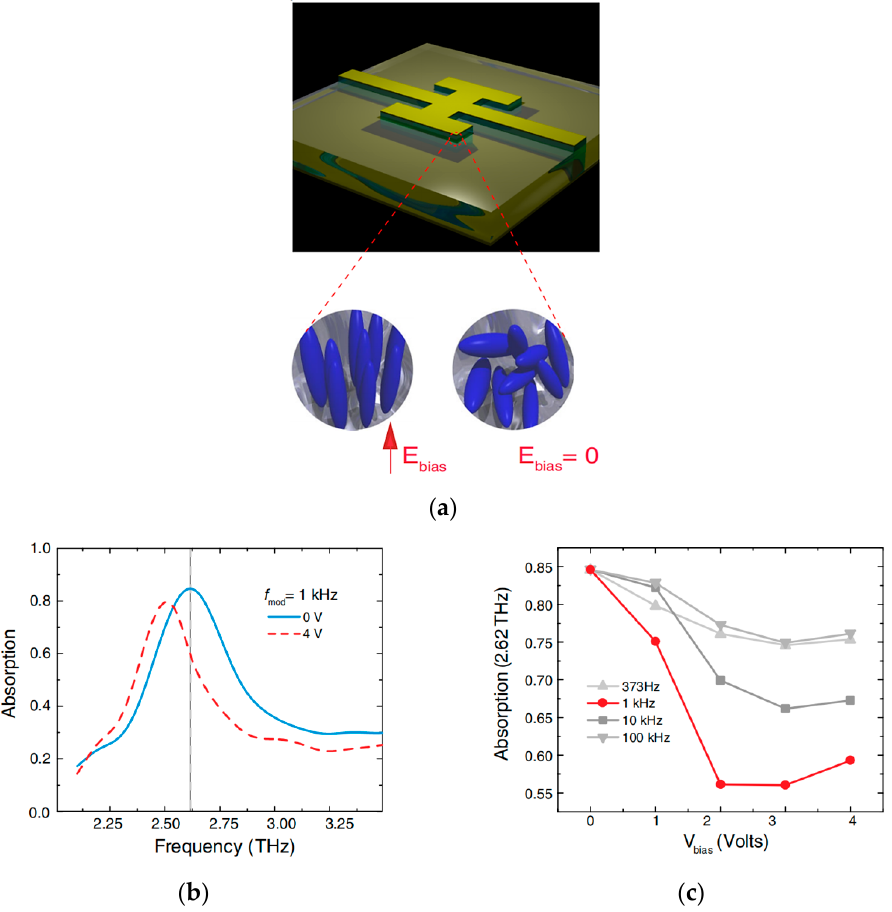
Figure 29. ( a ) Rendering of a single unit cell of the liquid crystal metamaterial absorber; ( b ) fre- quency dependent absorption for 0 V (blue solid curve) and 4 V (red dashed curve) at f mod = 1 kHz; ( c ) the absorption value at 2.62 THz as a function of bias voltage (V bias ) for various modulation fre- quencies [67].